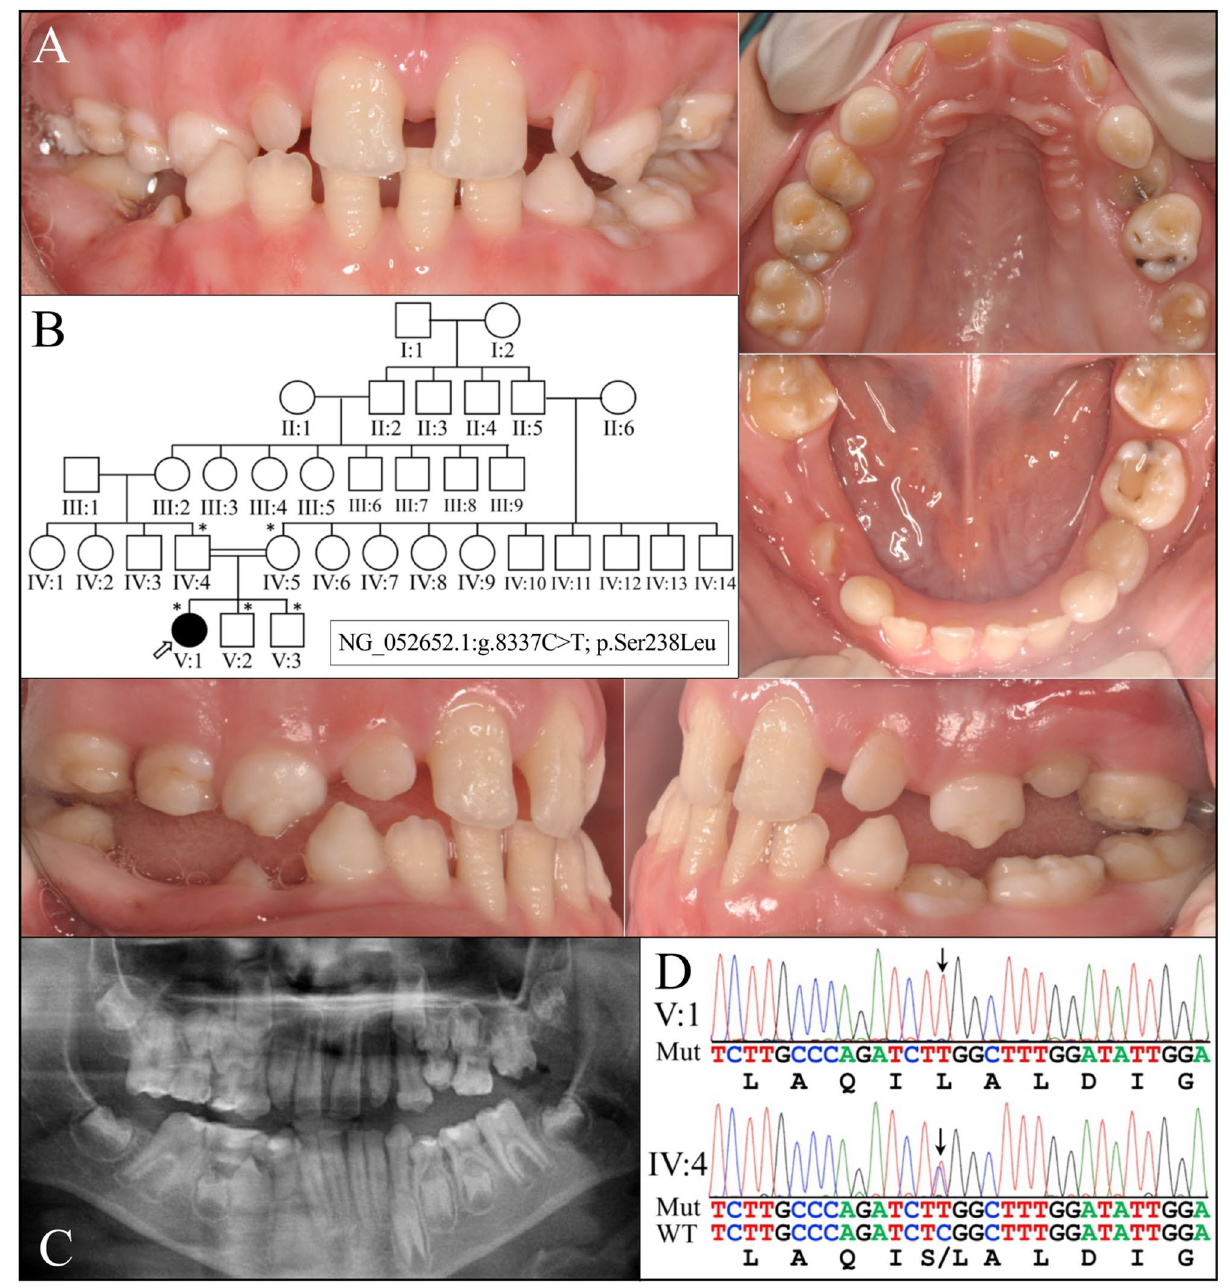
Figure 2. Family 2 with AI Type IJ (OMIM #617297). ( A ) Intraoral photograph of the proband (V:1) at age 9 showed a mixed dentition with enamel hypoplasia on both primary and permanent teeth. Horizonal hypoplastic bands were evident on the labial surface of lower incisors. ( B ) The pedigree indicated a 5-generation consanguineous family with the proband being the only individual with enamel malformations. ( C ) Panorex of the proband demonstrated that her unerupted teeth had extremely thin enamel, while the dentin and pulp chambers appeared normal. ( D ) DNA sequencing chromatograms revealed a reported ACP4 mutation in Exon 7 (NG_052652.1:g.8337C>T; NM_033068.3:c.713C>T, NP_149059.1:p.Ser238Leu), which was homozygous in the proband and heterozygous in all of her immediate family members (IV:4, IV:5, V:2, and